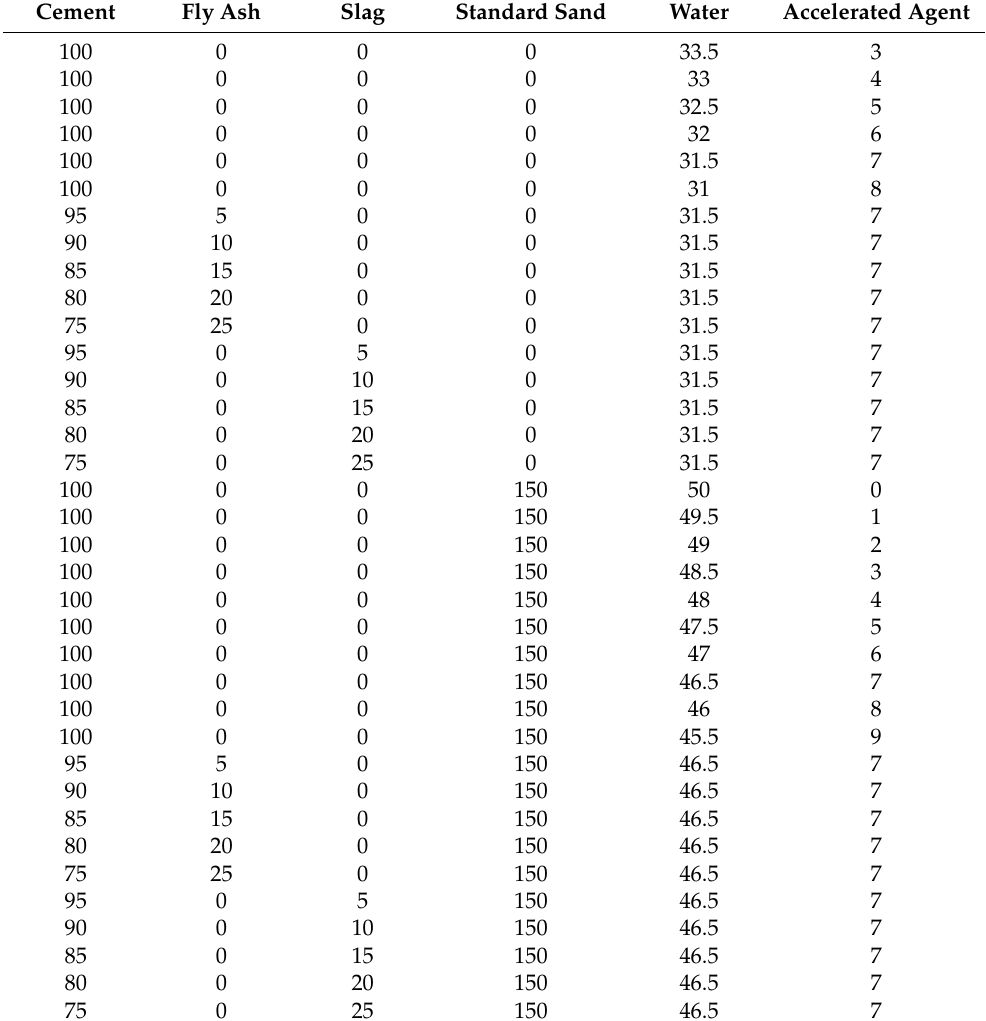
Table 2. The mix of specimens per unit